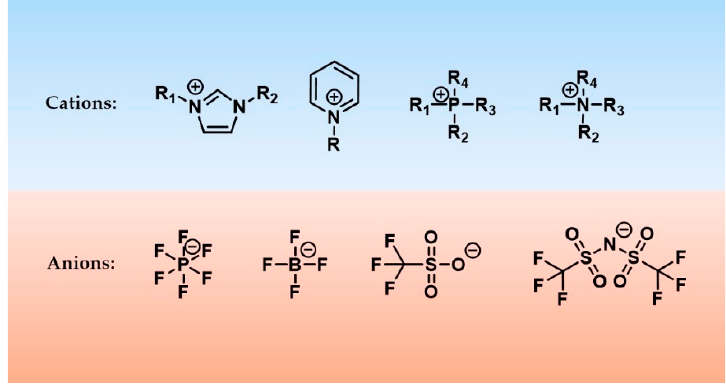
Figure 6. Common structures of ionic liquids.